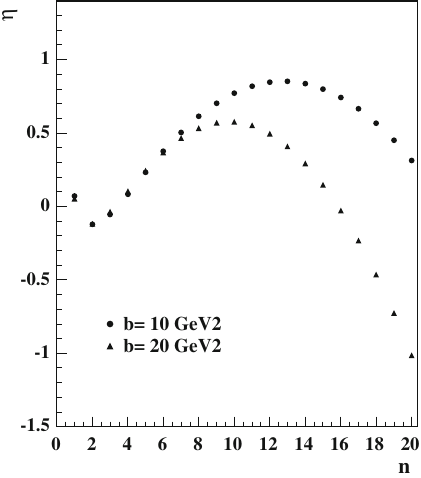
Fig. 8 η − n relation as computed from the parameters A , B of the AB fit